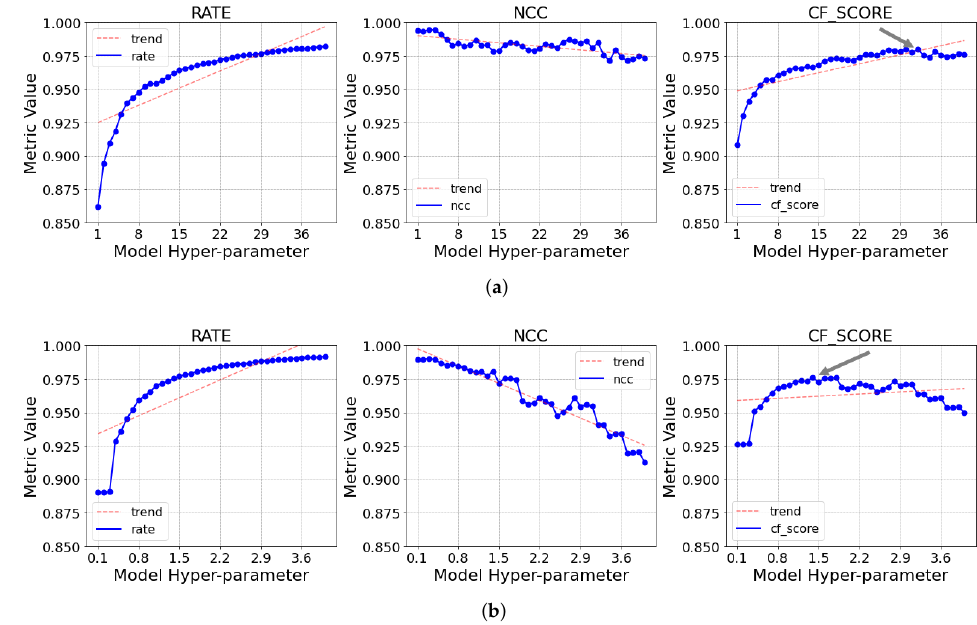
Figure 3. Variation of the compression rate, NCC, and CF score for the grid-search evaluated by varying the hyperparameter for the TAC and SDT models. β = 1. ( a ) TAC (Auto- m ); ( b )